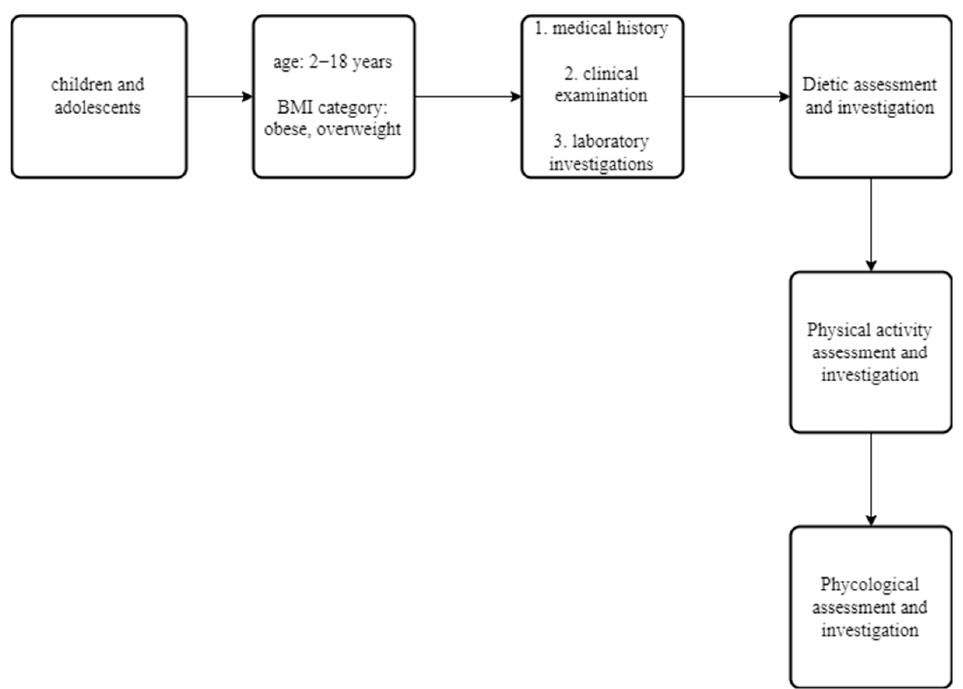
Figure 1. Flowchart of methodology used in the multidisciplinary, life ‐ style intervention program.